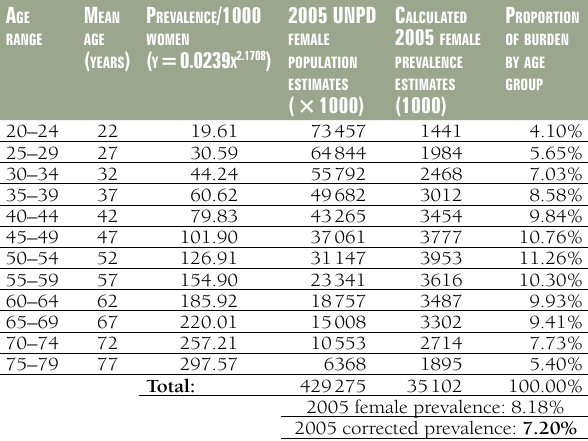
Figure 7. Male and female prevalence of type 2 diabetes in Southern Asia in 2005, adjusted to an “envelope” defined by all studies with prevalence data.